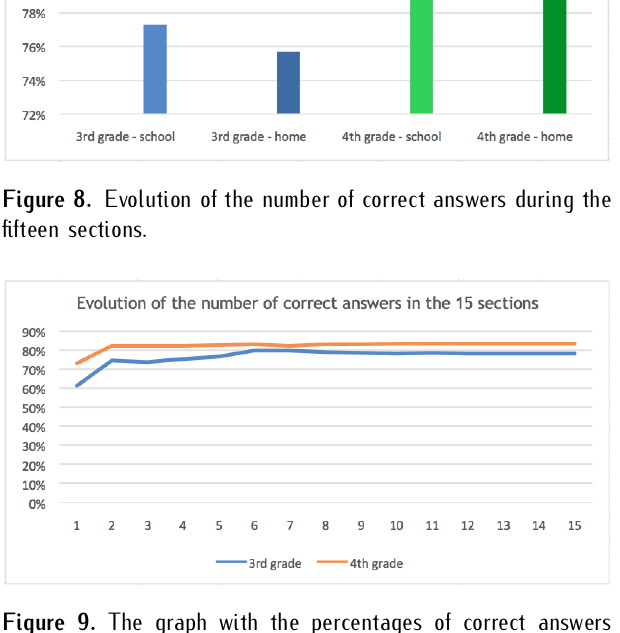
Figure 9. The graph with the percentages of correct answers divided by groups and